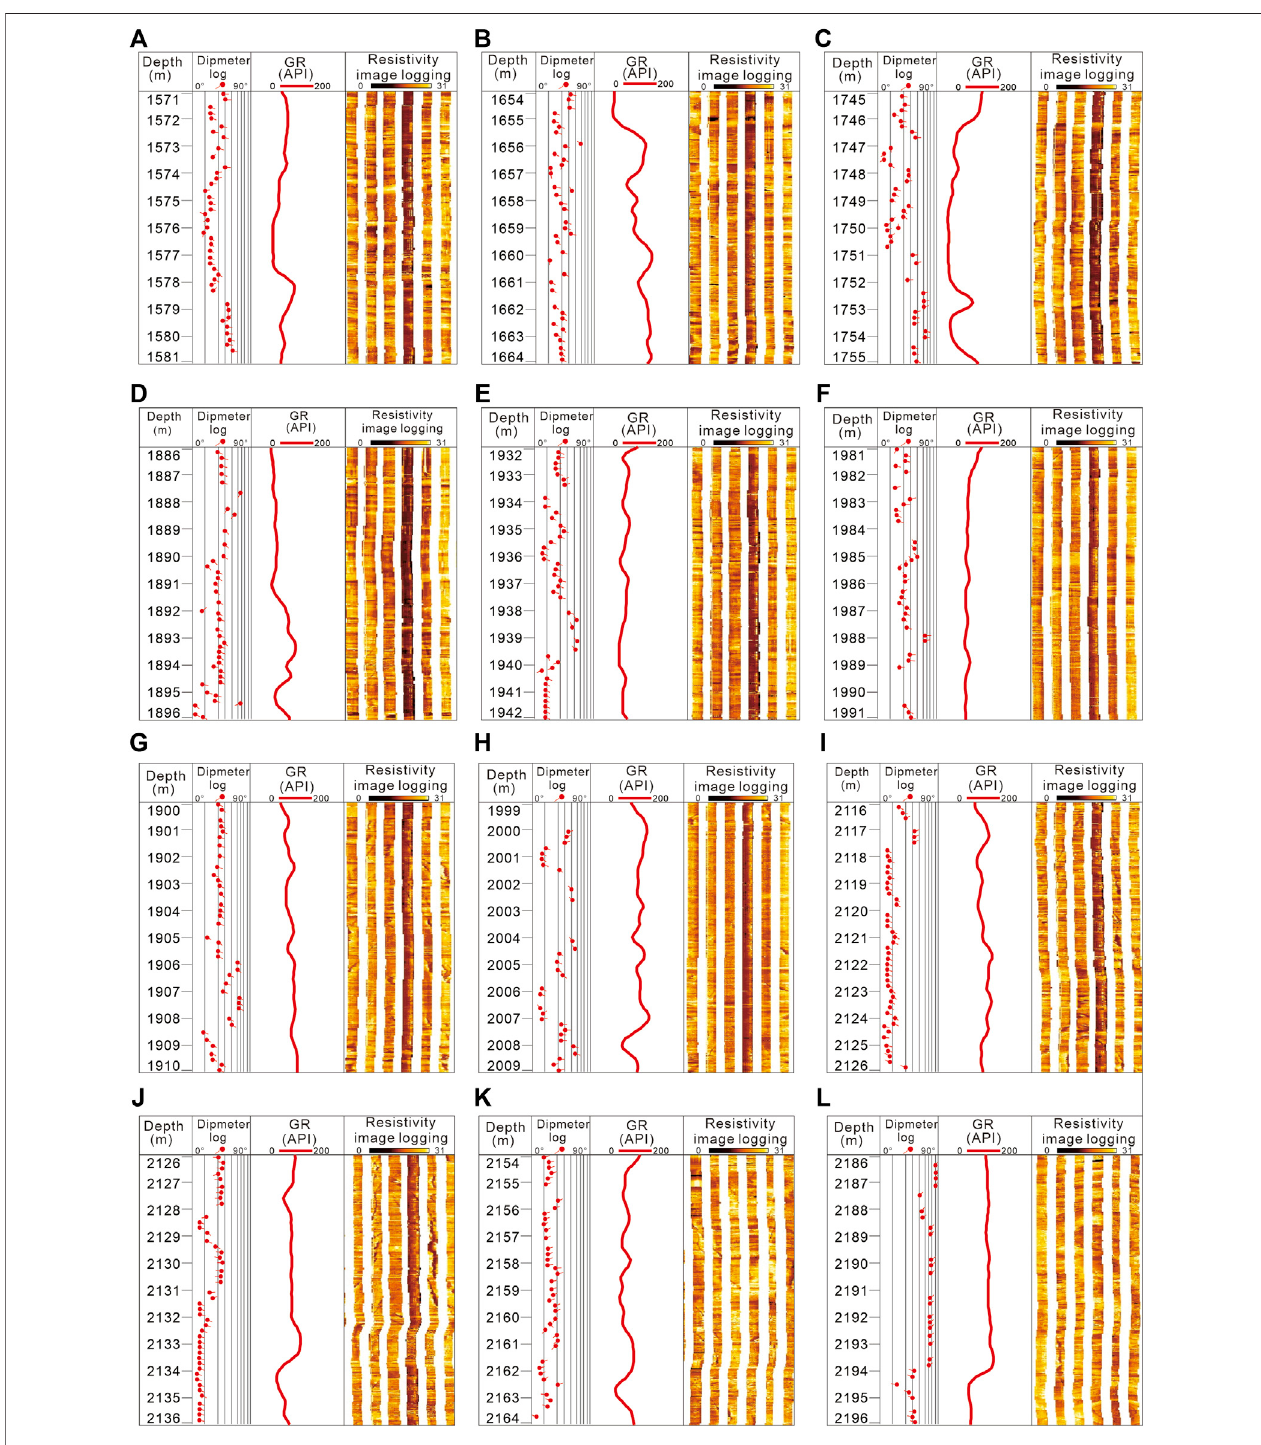
FIGURE 8 | Resistivity imaging logging map of different heterogeneous intervals. (A – F) : Massive bedding; (G – L) : Fracture.